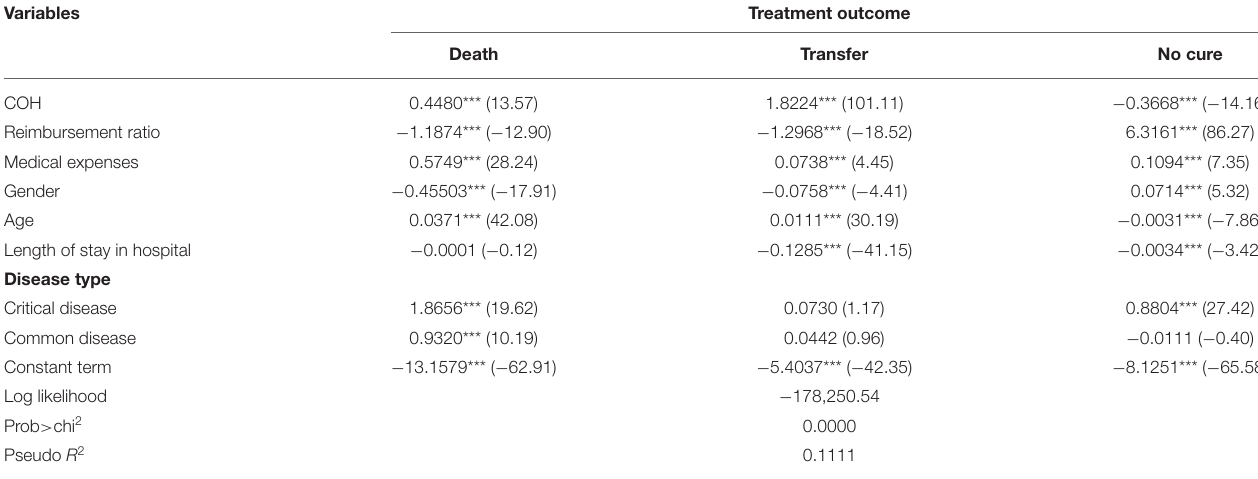
TABLE 6 | The NMNL model empirical results (by disease types).